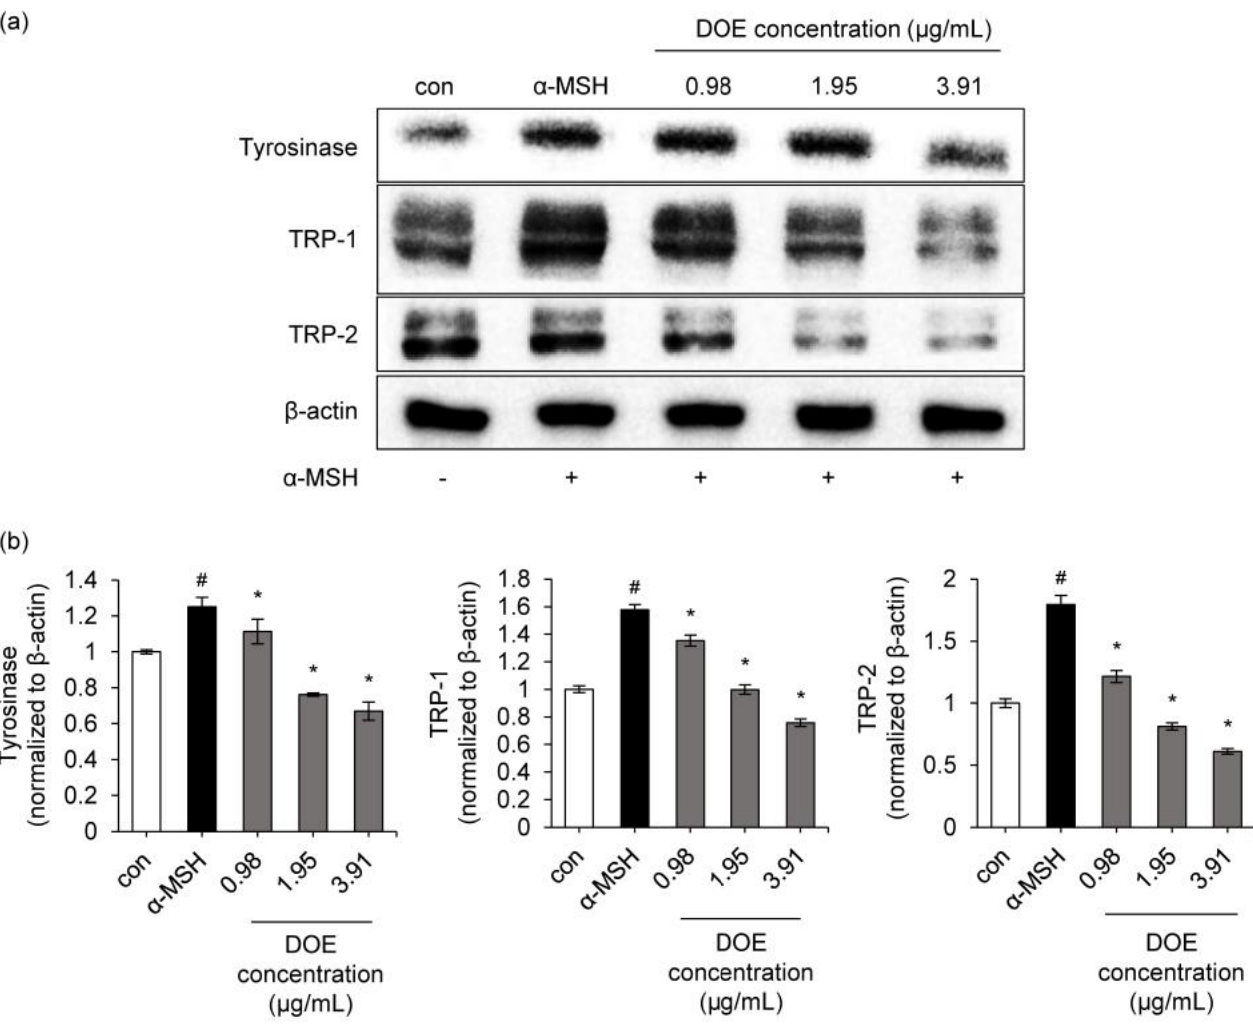
Figure 4. ( a ) Effect of DOE on the protein expressions of tyrosinase, tyrosinase-related protein-1 (TRP-1), and TRP-2 in B16F10 cells. B16F10 cells were treated with different concentrations of DOE ranging from 0.98 to 3.91 µ g/mL. Protein expressions of tyrosinase, TRP-1, and TRP-2 were analyzed by Western blotting. Equal protein loading was confirmed using β -actin antibody. ( b ) Protein level of tyrosinase, TRP-1, and TRP-2. The relative level of each protein was calculated based on the intensity of actin protein. # p < 0.05 vs. control. * p < 0.05 vs. α -MSH-treated group.